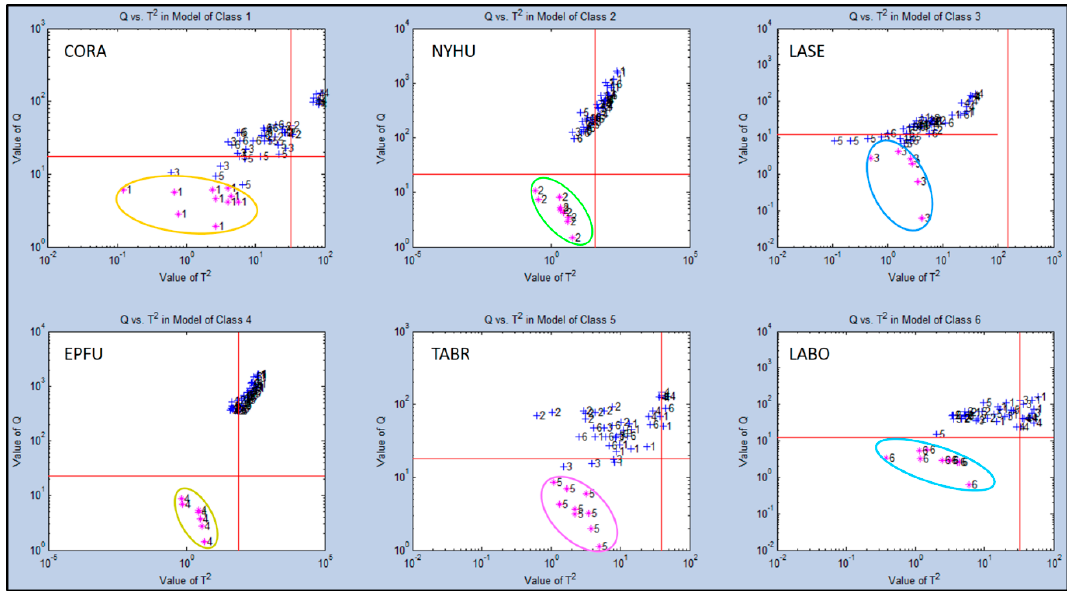
Figure 6. Analysis of aroma class ownership of C-320 e-nose VOC profiles based on bat air samples from six species (Test Group 1) using SIMCA Cross Validation (SIMCA-CV) secondary statistical tests. Analysis of Q-distance (Q-value) vs. score distance (T 2 -value) for each individual VOC aroma class (compared to all other classes) defined by VOC emissions from Class 1 = Corynorhinus rafinesquii (CORA), Class 2 = Nycticeius humeralis (NYHU), Class 3 = Lasiurus seminolus (LASE), Class 4 = Eptesicus fuscus (EPFU), Class 5 = Tadarida brasiliensis (TABR), and Class 6 = Lasiurus borealis (LABO).